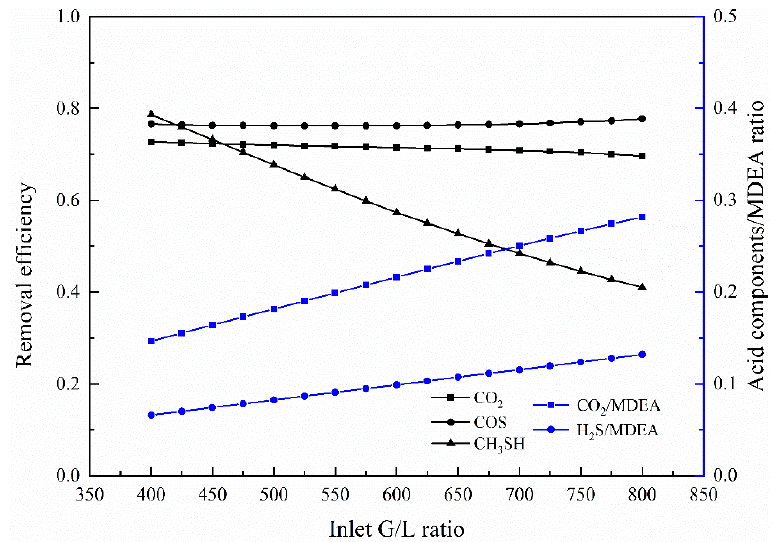
Figure 12. The effect of gas–liquid ratio on the removal efficiency and the acid components (CO 2 and H 2 S)/MDEA ratio (number of plates: 25; overflow weir height: 0.15 m; absorption pressure: 6 Mpa; inlet gas flow rate: 5.0 × 10 6 Nm 3 /d; inlet gas loading: CO 2 , 4.5 vol.%; H 2 S, 1.5 vol.%; COS, 15 mg/m 3 ; CH 3 SH, 15 mg/m 3 ).